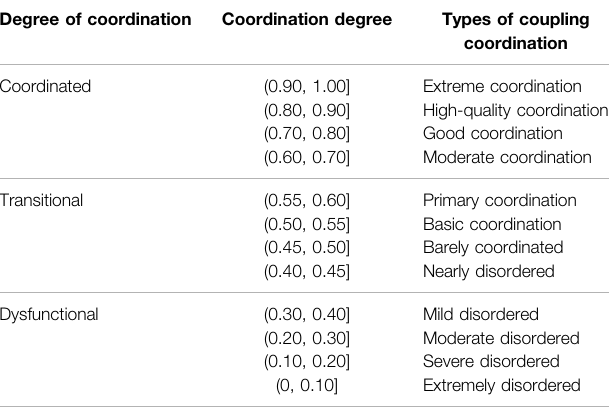
TABLE 3 | Classi fi cation system and criteria for coupling evaluation of water – land resources.